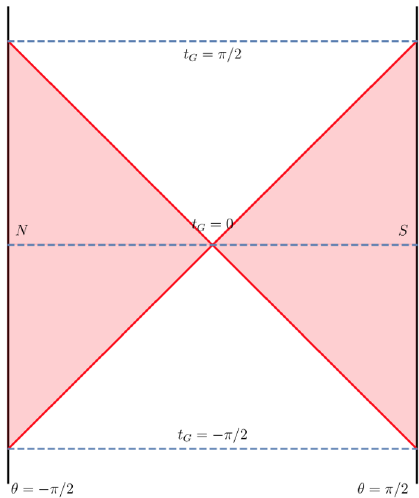
Figure 3. A portion of the periodic AdS 2 Penrose diagram near t G = 0 . The two vertical lines are the boundaries of AdS . The black hole solution in eq. (9.6) corresponds to the red θ = ± π 2 2 region denoted by “S”. The region “N” is the image of “S” under the map X 1 → − X 1 . The red lines represent the bifurcate Killing